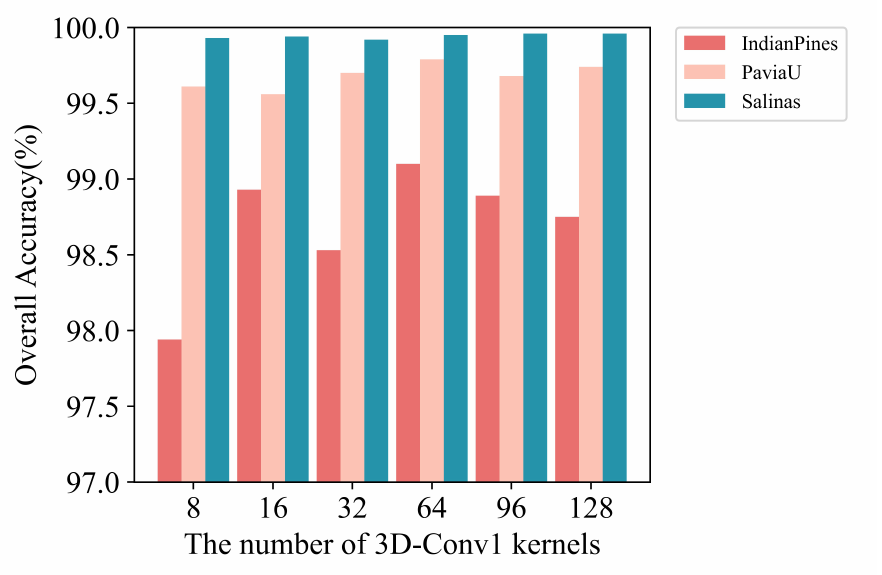
Figure 10. The OAs for the three datasets with the different 3D convolution kernel numbers.